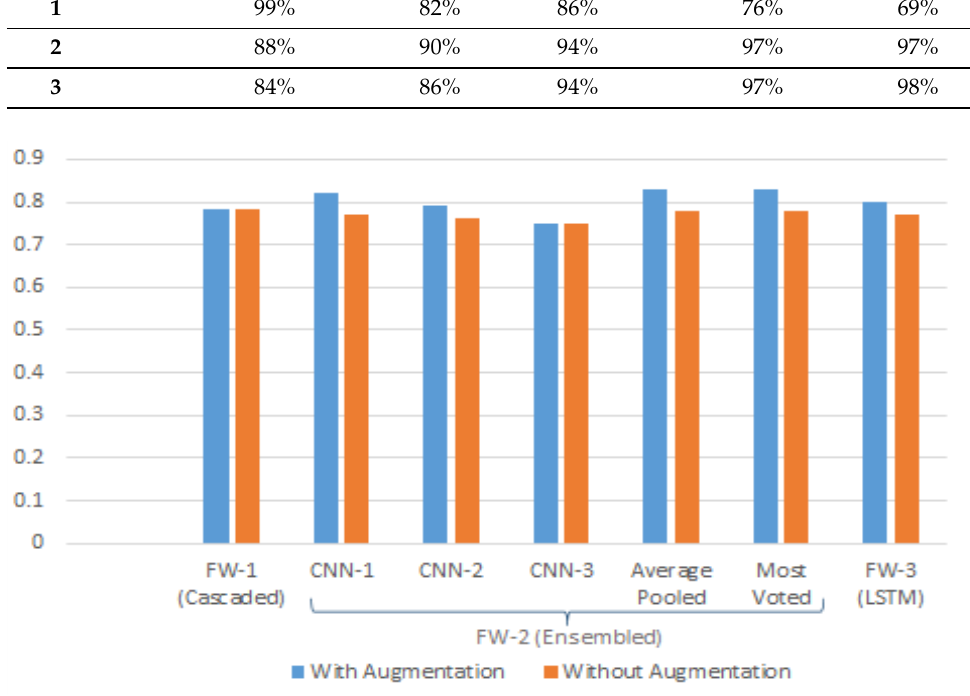
Figure 9. Performance comparison of proposed frameworks against augmented vs. non-augmented training